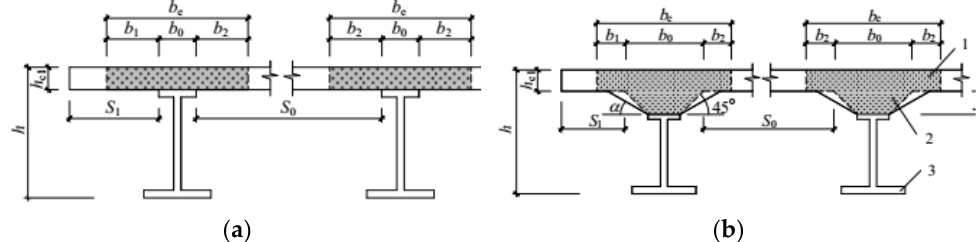
Figure 5. The effective width of a concrete flange in GB50017-2017 [24]. ( a ) Composite beam without bracket; ( b ) composite beam with bracket.